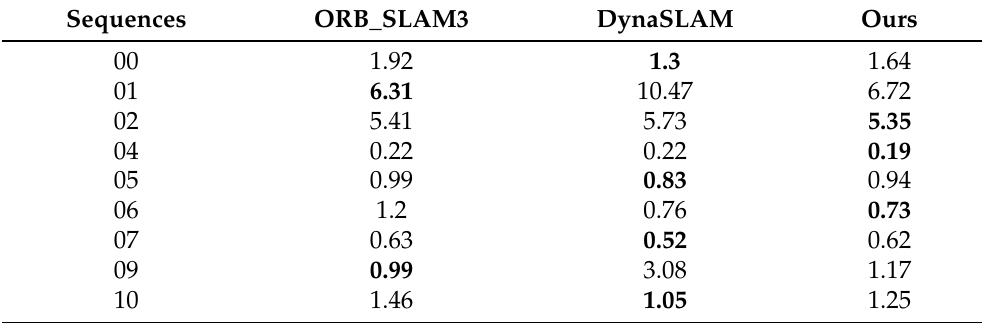
Table 8. Comparison of absolute trajectory error with DynaSLAM.